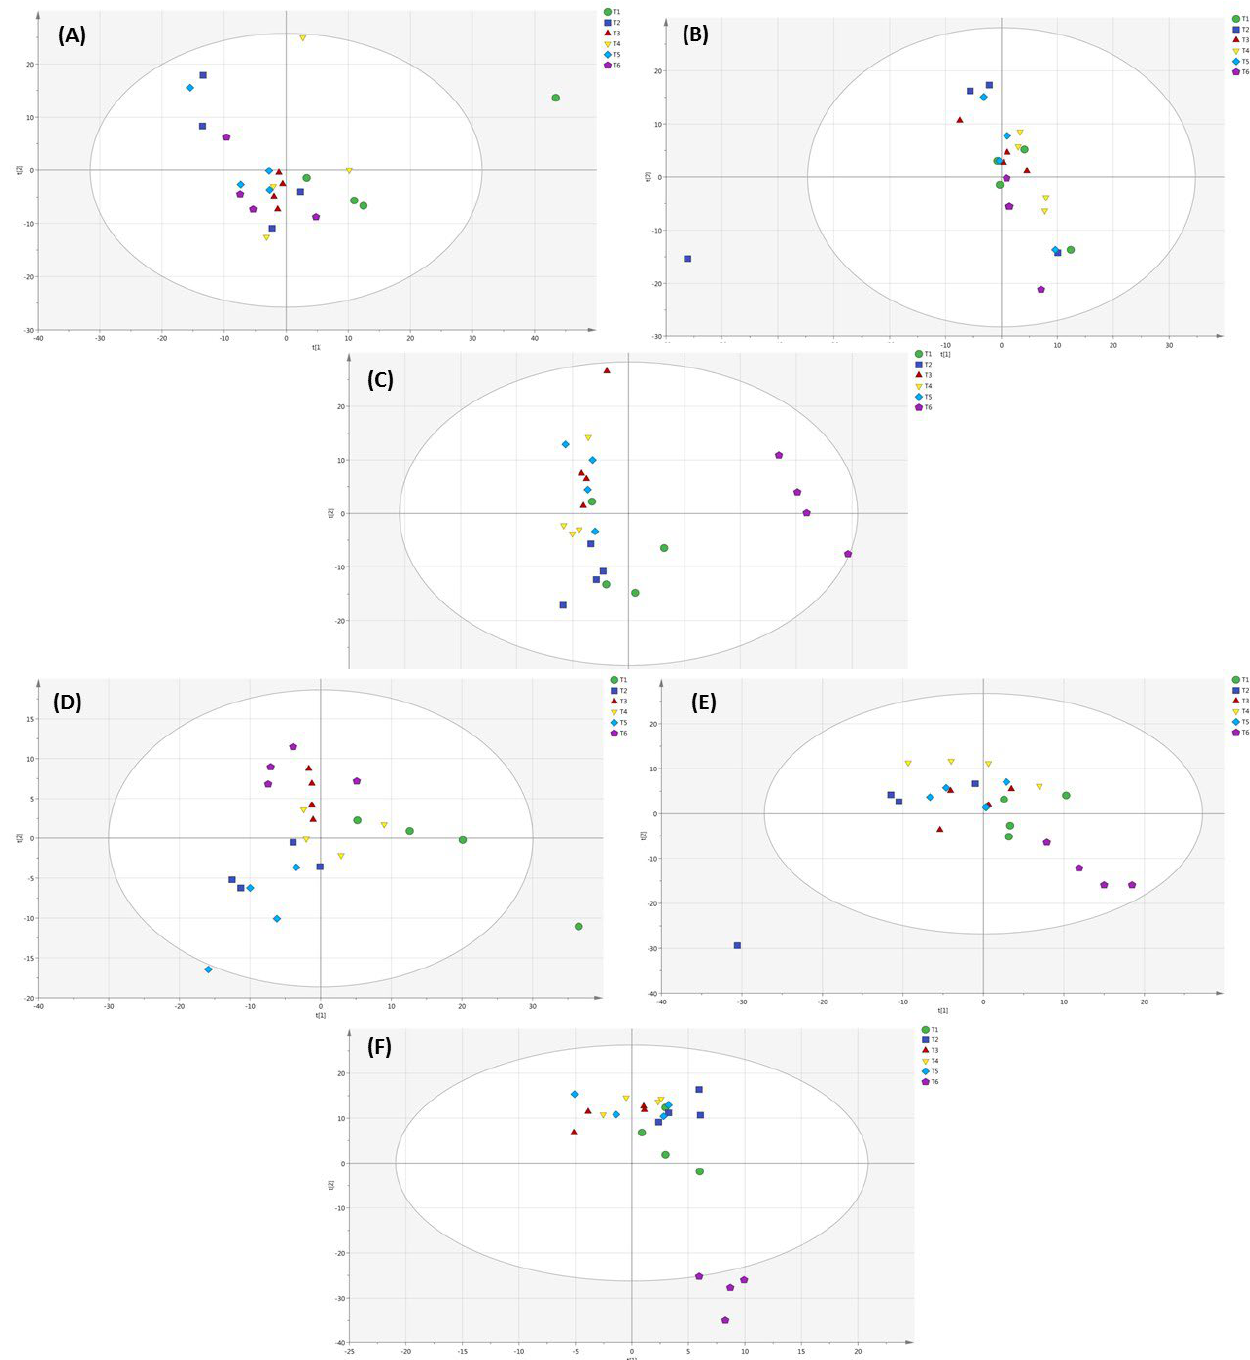
Figure 7. PCA and PLS-DA analysis of the metabolomic profile of lettuce with different applied NH 4+ / NO 3 − ratios (100:0, 75:25, 50:50, 25:75 and 0:100%) and control (no additional N applied) in soil, substrate and hydroponic cultivation systems by GC-MS analysis. Note- ( A – C ) represents PCA analysis and ( D – F ) represents PLS-DA analysis of metabolomic profiling of lettuce in soil, substrate and hydroponic cultivation systems by GC-MS analysis. Green color represents NH 4+ /NO 3 − (100/0%), blue color represents NH 4 + /NO 3 − (75/25%), red color represents NH 4 + /NO 3 − (50/50%), yellow color represents NH 4 + /NO 3 − (25/75%), sky-blue color represents NH 4 + /NO 3 − (0/100%) and purple color represents control. In PCA analysis of lettuce analyzed by UPLC VION IMS QTOF-MS/MS (Figure 8A), the 100% NH 4+/ 0% NO 3 − ratio showed a significant difference in the metabolomic profile of lettuce as